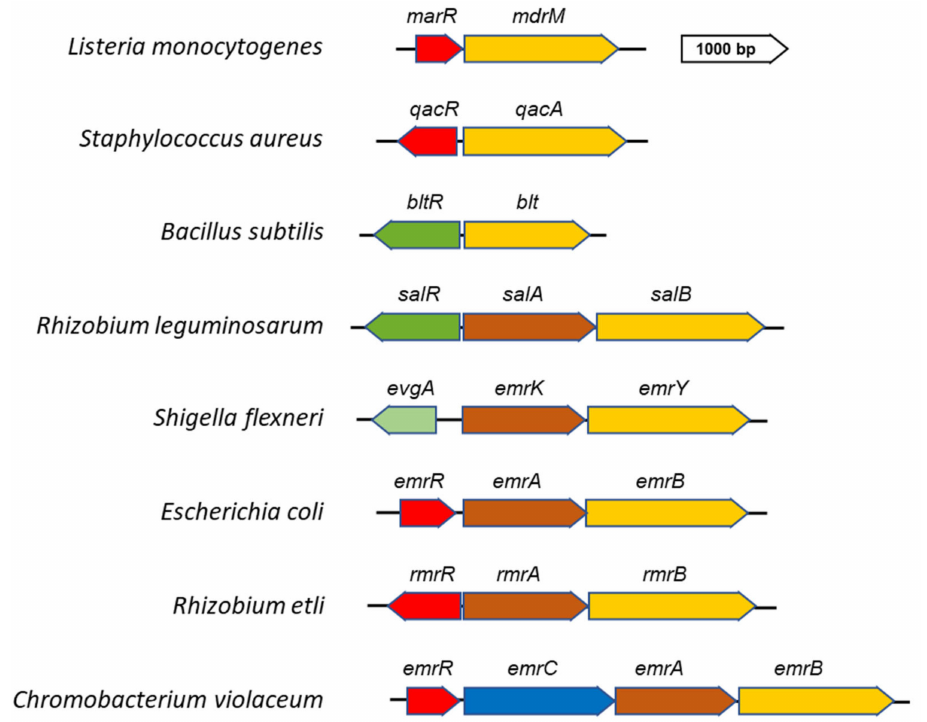
Figure 2. Genetic organization of representative MFS e ffl ux pumps (EP) encoding genes and their local regulators. MFS transporters are encoded by chromosomal or plasmid genes. The genes encoding the inner membrane transporter (yellow) and the periplasmic adaptor protein (brown) are part of a single operon. The outer membrane channel protein (blue) may be encoded by the same operon or by another genetic locus, as in the case of the tolC gene. The transcriptional regulation of MFS EP genes is controlled mainly by local regulatory genes encoding repressors (red) or activators (green). In general, local regulators allow the expression of MFS EP operons in response to the substrates they export. Repressors belong to the TetR-, MerR- or MarR- families while activators belong to LysR- or MerT-families. The evgA gene (light green) encodes the regulator of a two-component system (EvgA / EvgS) which activates the emrKY operon in response to high concentrations of alkaline metals under mild acidic concentrations, as found inside macrophages. Global regulators are not shown